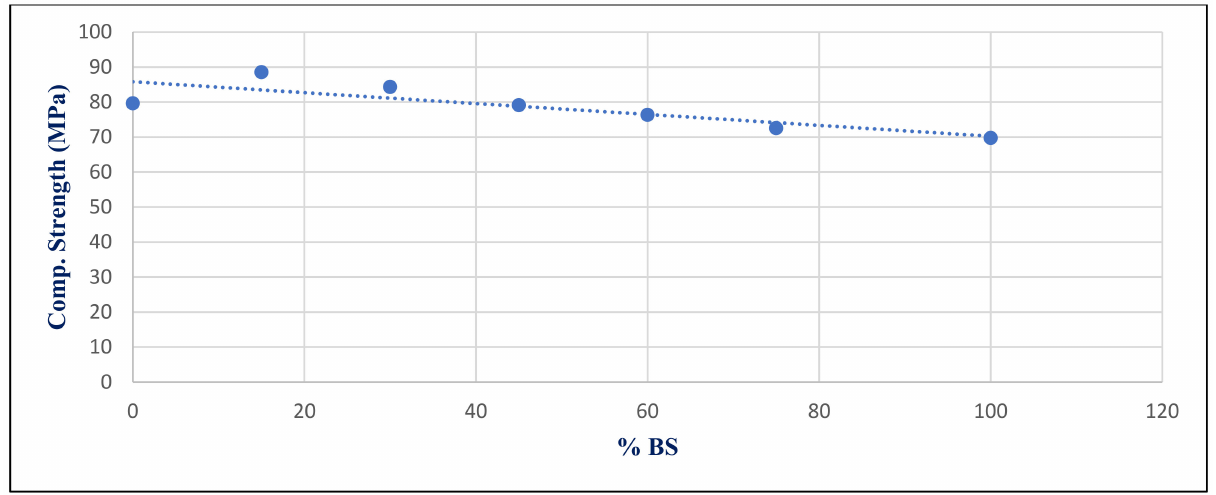
Figure 32. Correlation relation between compressive strength under sulfate exposure conditions and %BS for group Z at day 365.